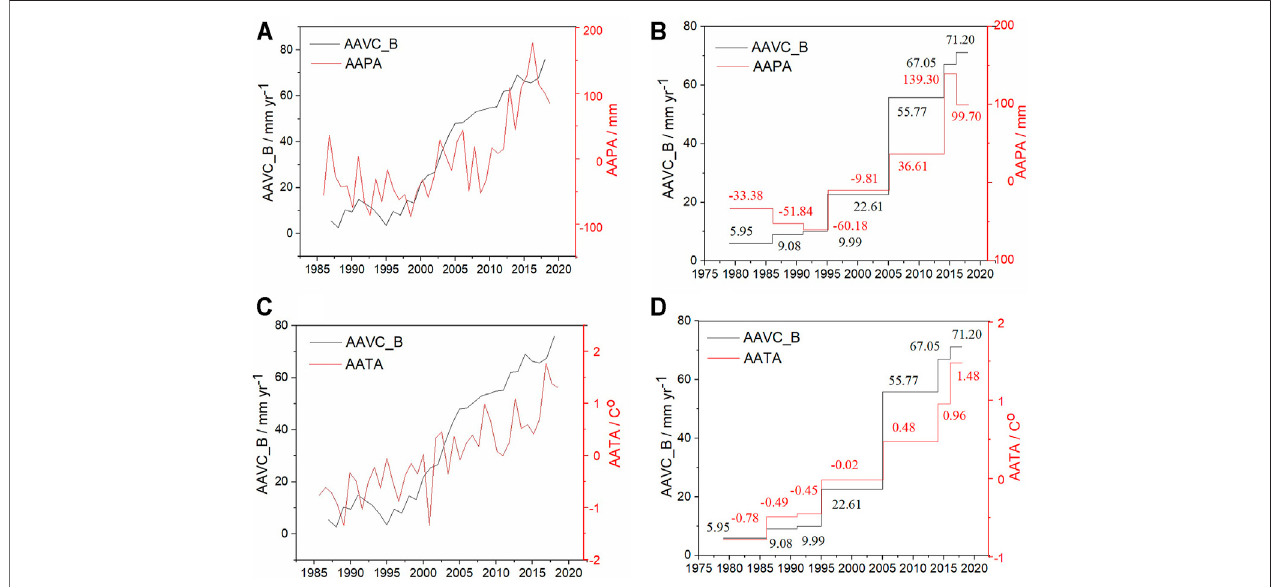
FIGURE6|(A) Overallchangesinlakevolumeandprecipitation; (B) AAVC_Band precipitation changeindifferentperiods; (C) Overallchangesinlakevolumeand temperature; (D) AAVC_B and temperature changes during different periods.